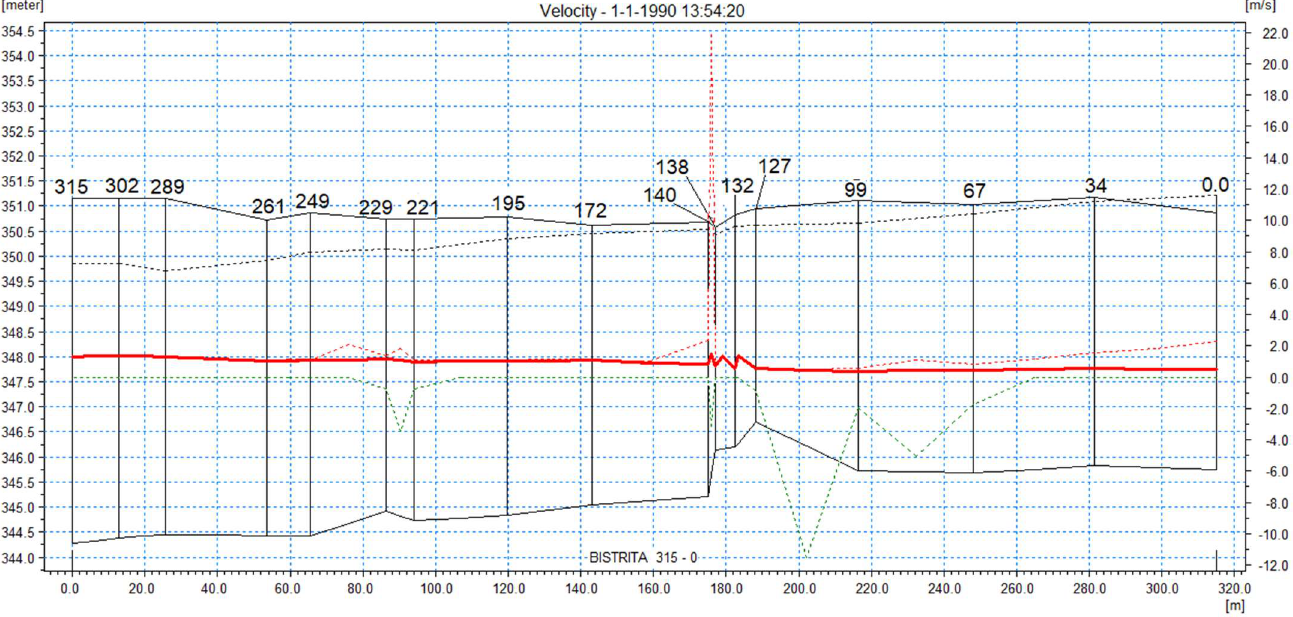
Figure 9. Water speed for flow Q = 8.37 m 3 /s, the average annual flow calculated for the year 2021. For the case where there is only one weir, the existing one.